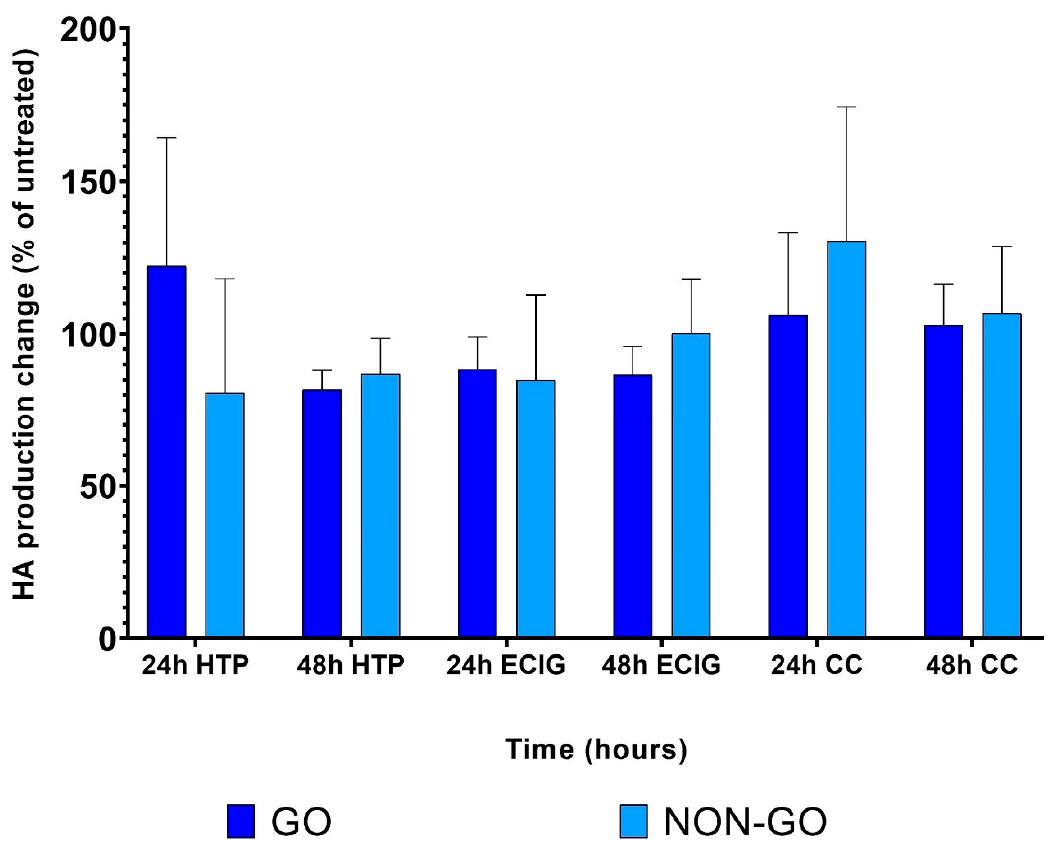
Figure 8. The effect of 1% HTP, ECIG and CC on hyaluronan production of GO and NON-GO cells. The results are shown as % of untreated (mean ± SD). Data were analyzed using paired t -test. All experiments were performed in triplicates.